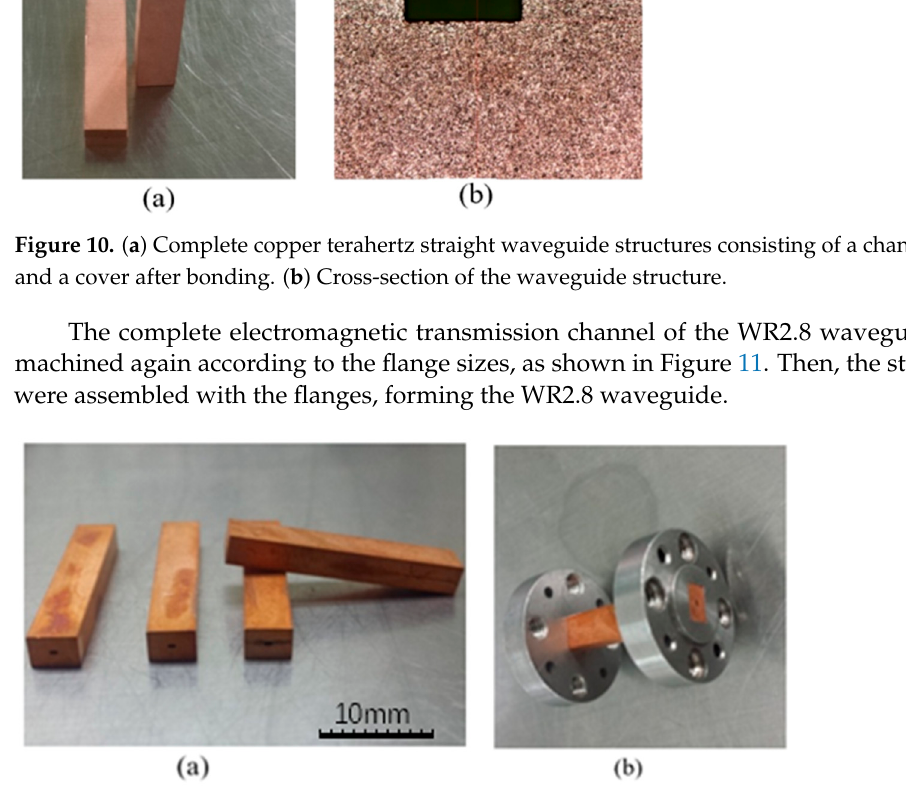
Figure 11. ( a ) The complete electromagnetic transmission channels of the WR2.8 waveguide after secondary machining. ( b ) The WR2.8 waveguide with flanges.